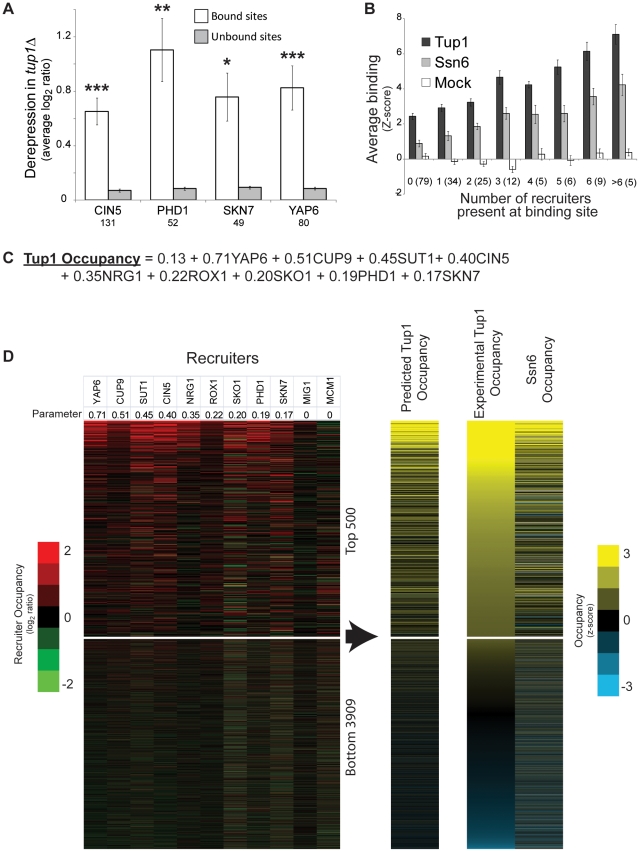
New Tup1 recruiters improve the model for Tup1 recruitment.(A) The average downstream gene expression for the targets (P<0.001) and non-targets (P>0.05) of the four new recruiters in tup1Δ strain is plotted [7]. The number of sites is listed and error bars represent standard error. The significance for the difference between the bound (P<0.001) and unbound sites (P>0.05) was determined by t-Test; * P<0.001, ** P<1×10−4, *** P<1×10−5. (B) Tup1 targets were separated based on the number of recruiters bound (P<0.001; [30]), including the four new candidate recruiters (Cin5, Phd1, Yap6, and Skn7). The average enrichment (Z-score) for Tup1, Ssn6, or Mock experiment for each group is shown. The number of targets in each group is shown in parenthesis and error bars represent standard error. (C) Regression model including new candidate recruiters. This model describes how recruiter occupancies, as measured by ChIP-chip, can be used to predict Tup1 occupancy at a genomic region. (D) The log2 ratio for each Tup1 recruiting protein is shown on the left, with the parameter estimate for the regression model on top. Tup1 binding predicted by the model is shown with the experimental Tup1 and Ssn6 occupancy. All data is sorted by the experimental Tup1 occupancy.